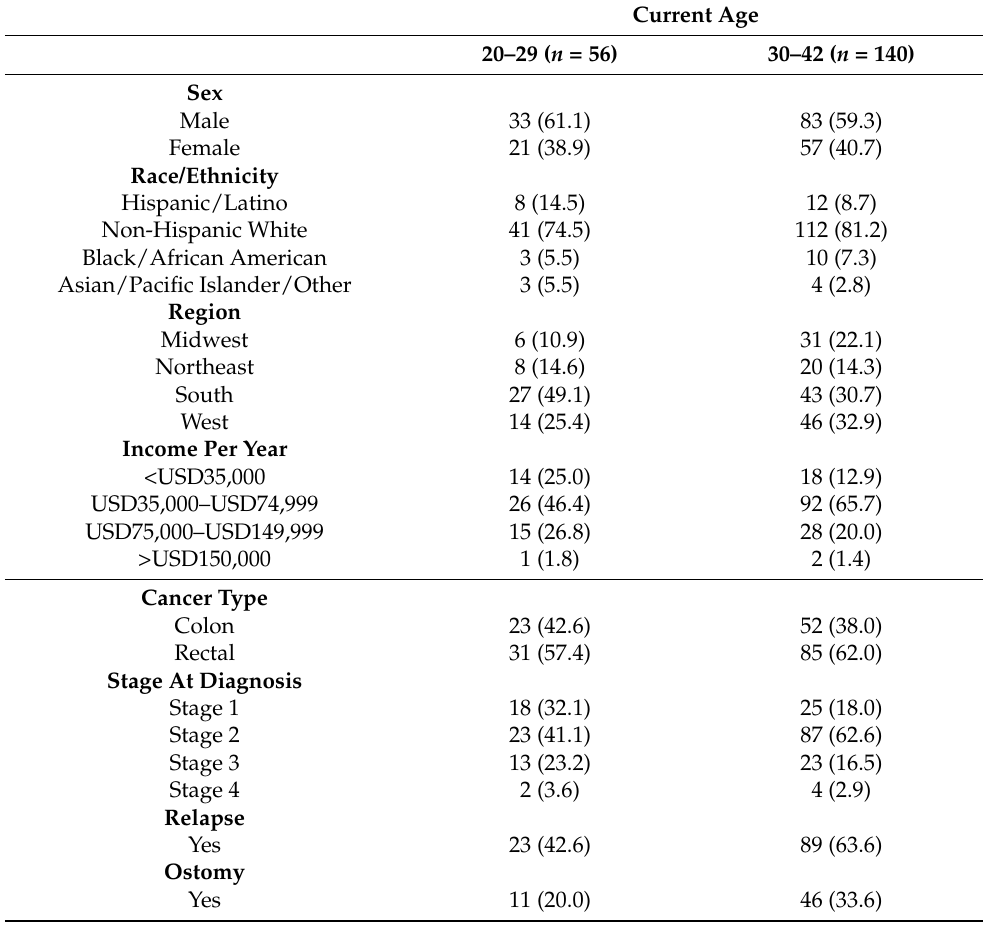
Table 1. Characteristic of the sample overall and by age category n =